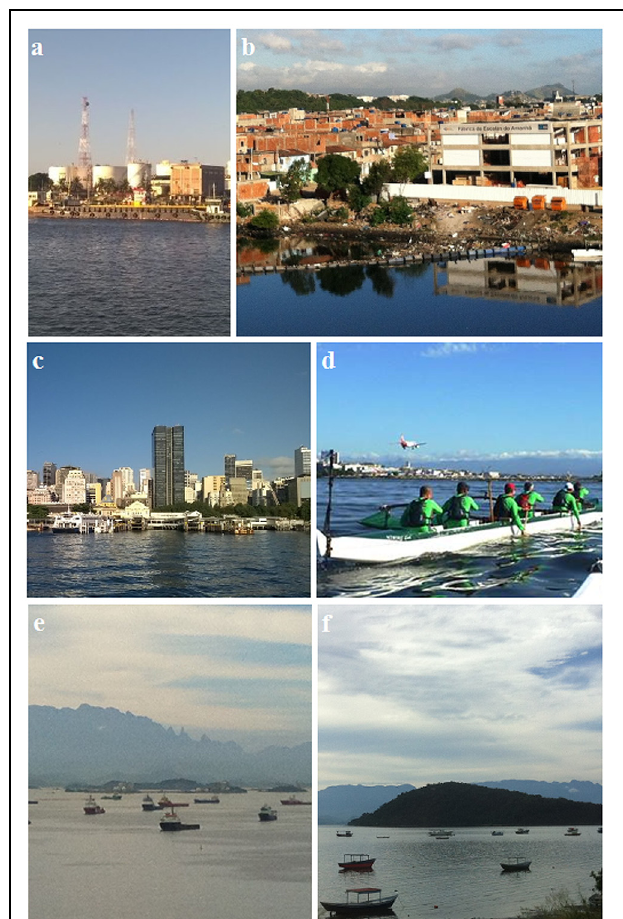
FIGURE 1 | Composition of pictures showing degraded (a,b) and non-degraded areas of Guanabara Bay (f), which still have some fringing mangrove system. There are different urban landscapes surrounding the bay, such as industries (a) , slums (b) , metropolis (c,d) . The bay has social-economic importance and it is used, among others, as harbor (e) , for artisanal fisheries (f) , and recreational purposes (d) . Pictures by: (a) and (c) : Michelle Vils; (d) : Wanderson F. de Carvalho; (b, e) and (f) : Giovana O.